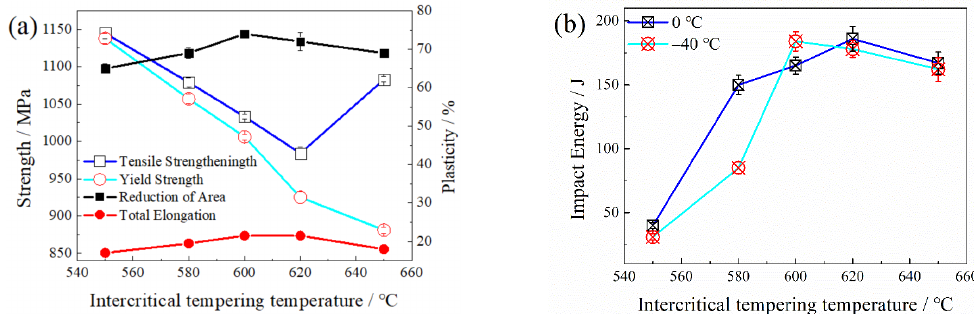
Figure 2. Mechanical properties after tempered at different temperatures: ( a ) strength and plasticity and ( b ) impact energy.